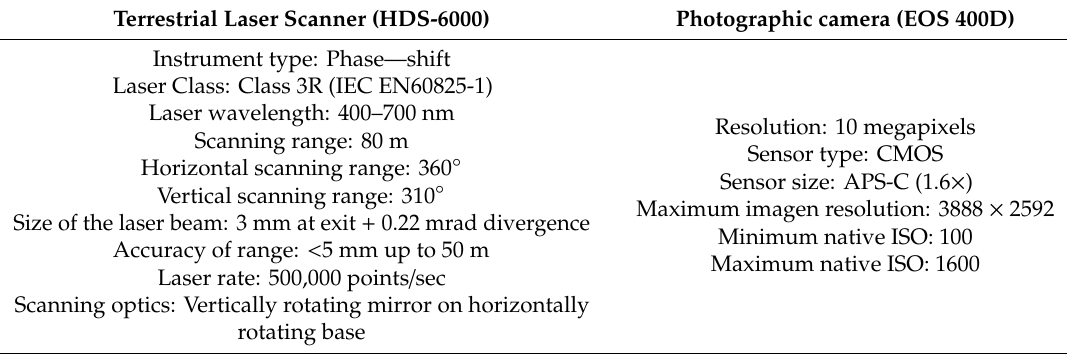
Table 1. Main technical specifications of the